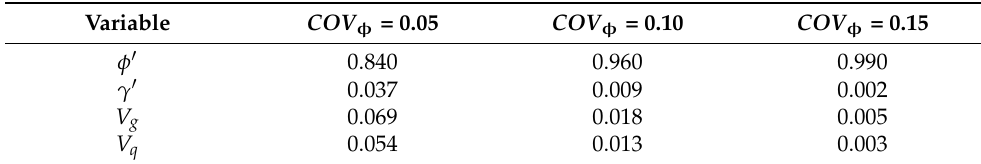
Table 5. First order Sobol indices of the ULS limit state function of shallow foundation in non- coherent soil.